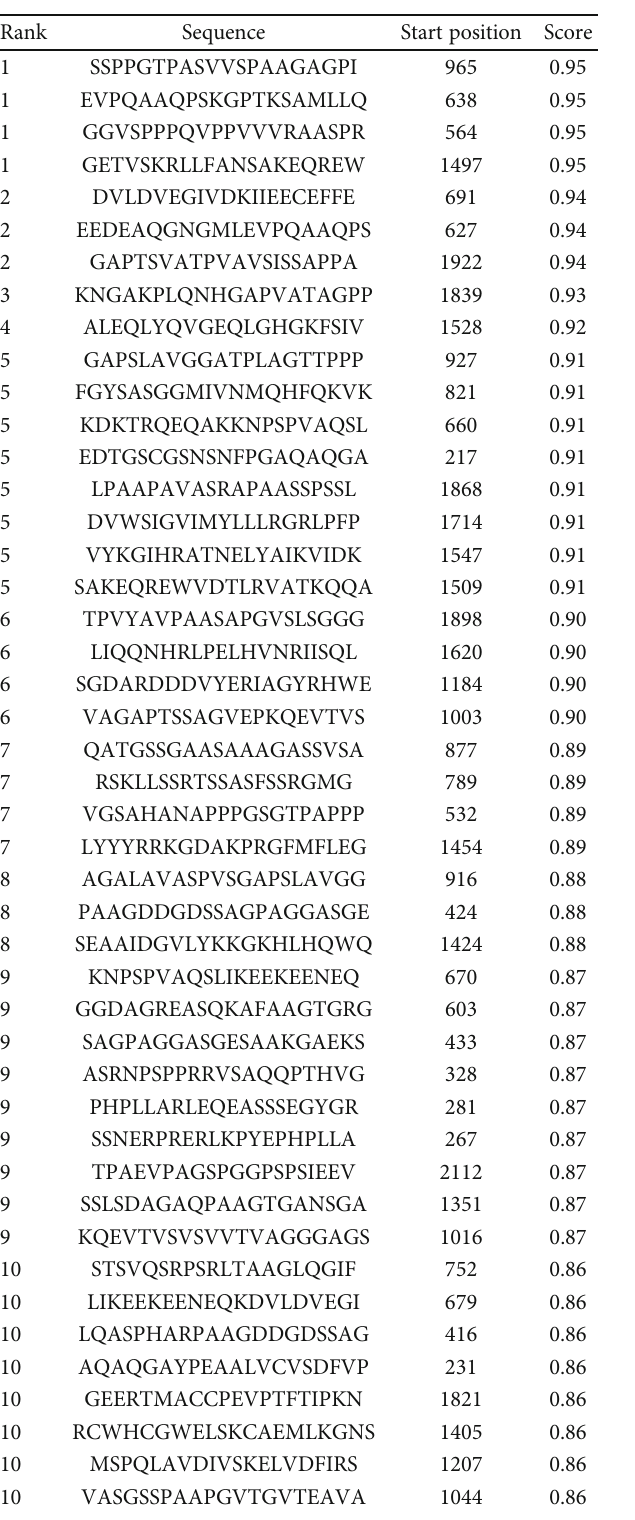
Table 3: The predicted B-cell epitopes via the ABCpred